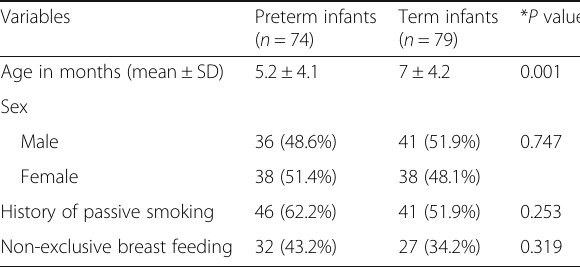
Table 1 Demographic characteristics of preterm and term infants with bronchiolitis, Cairo University Specialized Pediatric Hospital